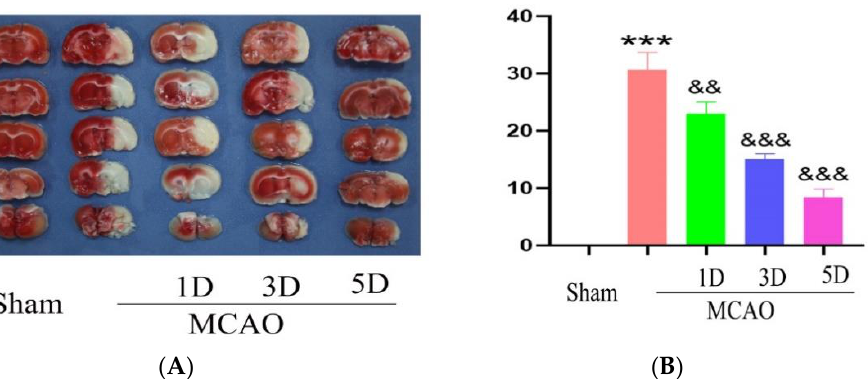
Figure 1. The cerebral infarction volume were detected with TTC staining method following middle cerebral artery occlusion and treadmill exercise ( A ) TTC staining method was used to detect brain sections of mouse with middle cerebral artery occlusion and treadmill exercise 1D, 3D and 5D; White is the cerebral infarction area, and red is normal area. ( B ) Statistical analysis of cerebral infarct volume in ( A ). (*** p < 0.001 vs. Sham; && p < 0.01, &&& p < 0.001 vs. MCAO) n = 5.